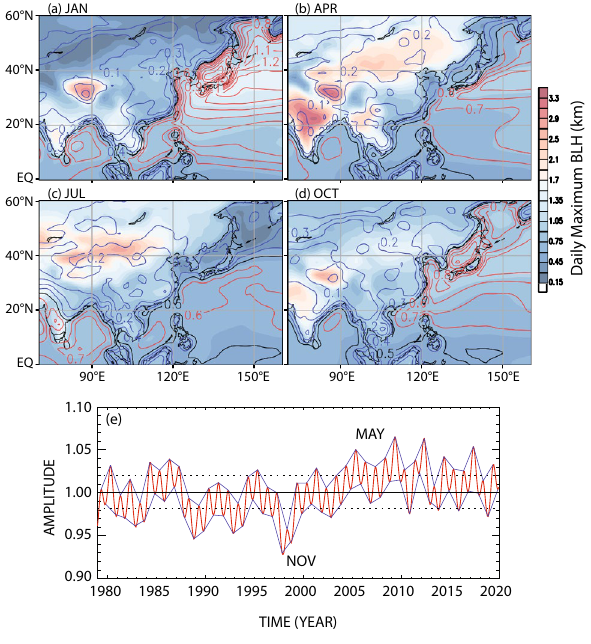
Fig. 1 a – d The seasonal patterns of daily maximum (shade; km) and daily minimum (contour lines; km) height of planetary bound- ary layer for the first CSEOF mode (diurnal/seasonal cycle). e The normalized PC time series of the seasonal cycle. Contour interval is 0.1 km with the black contour at 0.5 km (blue < 0.5 km < red). The blue curves in e denote the PC time series in May and November, and the blue dotted lines represent their mean